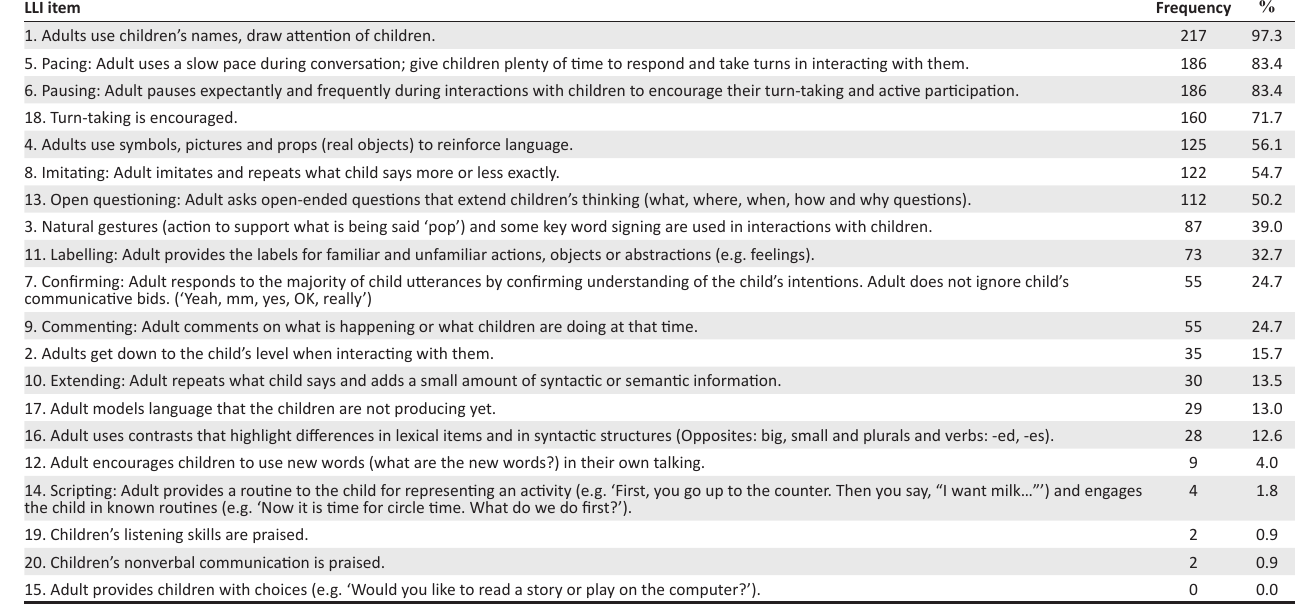
TABLE 3: Number and proportion of observations that indicated a score ≥ 3 in each item of the language-learning interaction area ( N = 223). LLI